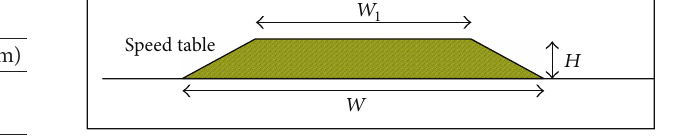
Figure 3: Geometrical cross section of speed